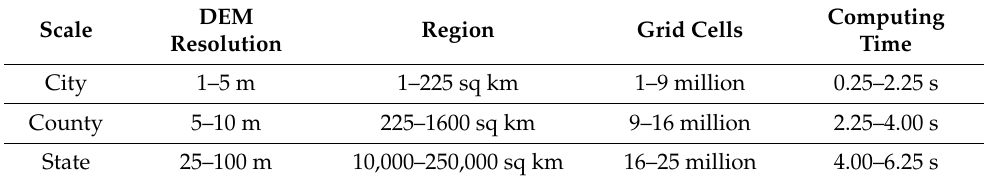
Table 3. Computing time for generating flood extent in different scales and resolutions.